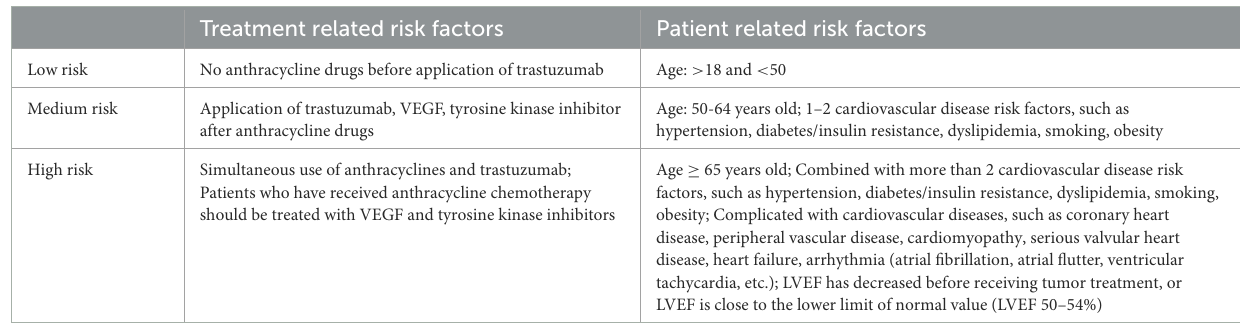
TABLE 2 Risk stratification of cardiovascular toxicity associated with targeted drugs for breast cancer. Treatment related risk